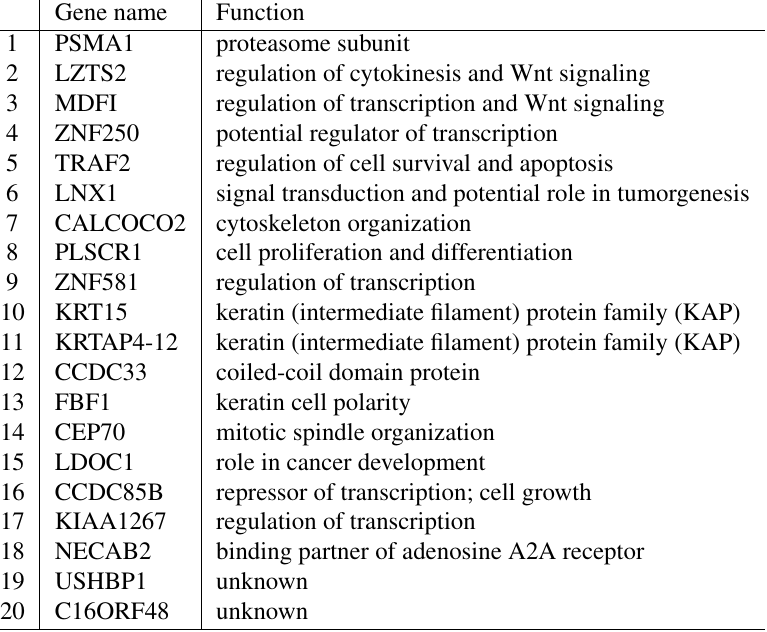
Table 4: The biological function of the 20 proteins from the conserved core across the three ver- sions of the human